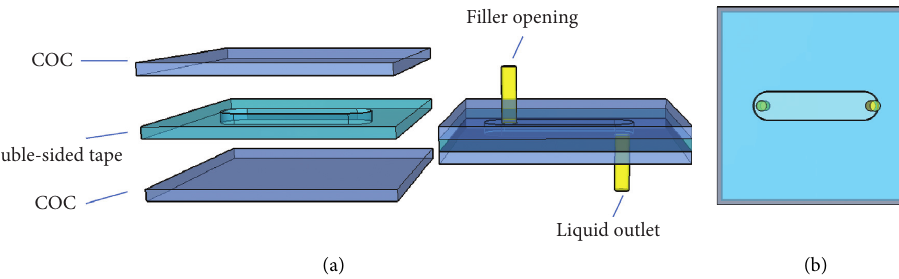
Figure 2: Schematic diagram of the microfluidic chip: (a) schematic diagram of the preparation process; (b) chip top